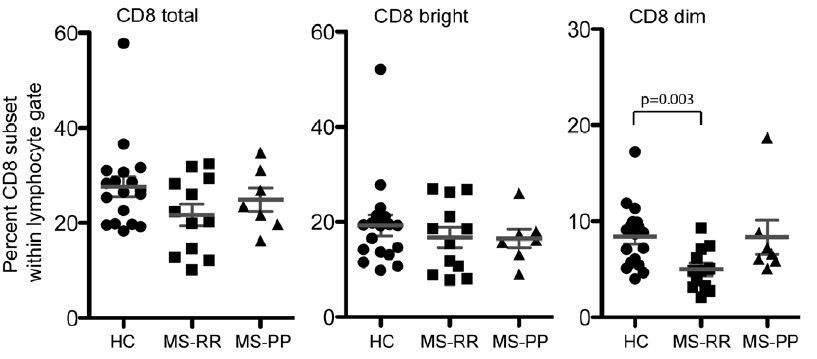
Figure 2. MS-RR patients have reduced percentage of CD8 dim cells. Mononuclear cells from HC, MS-RR, and MS-PP was incubated with fluorophor-conjugated anti-CD8 antibody and examined by flow cytometry for the presence of CD8 total, CD8 bright , and CD8 dim cells. Comparisons are done using Mann-Whitney U-test.